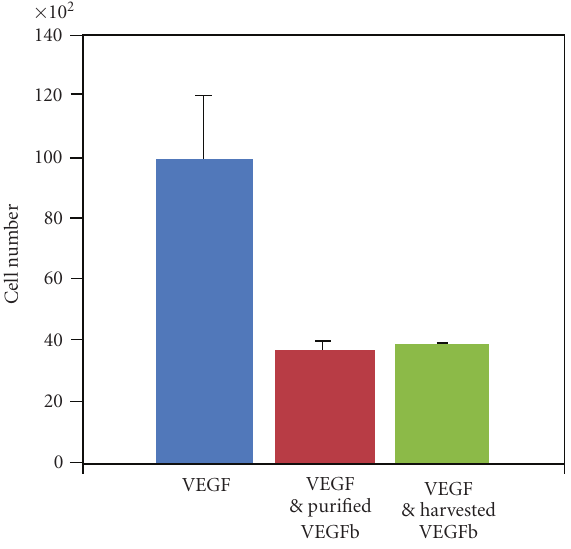
Figure 4: The e ff ects of VEGF and VEGF 165 b on HUVECs proliferation. The cells received 25ng/ml VEGF, 25 ng/ml VEGF and two-fold purified VEGF 165 b or 25 ng/ml VEGF and two-fold harvested VEGF 165 b from microencapsulated HEK293 VEGF 165 b producing cells after overnight starving from serum and growth factors. HUVEC proliferation was determined after 72 hours by MTS-based assay. Purified VEGF 165 b and harvested VEGF 165 b from encapsulated HEK293 VEGF 165 b producing cells o ff ered similar results in inhibition of cell proliferation, n = 3, P = .